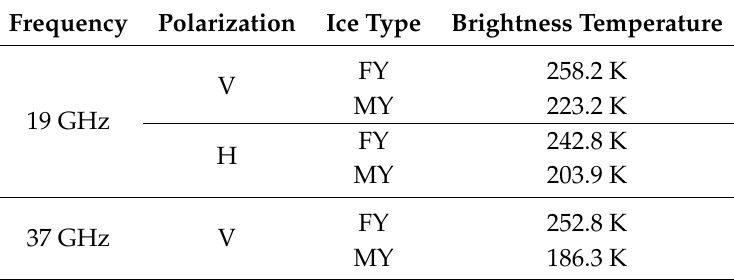
Table 2. NASA Team Tie